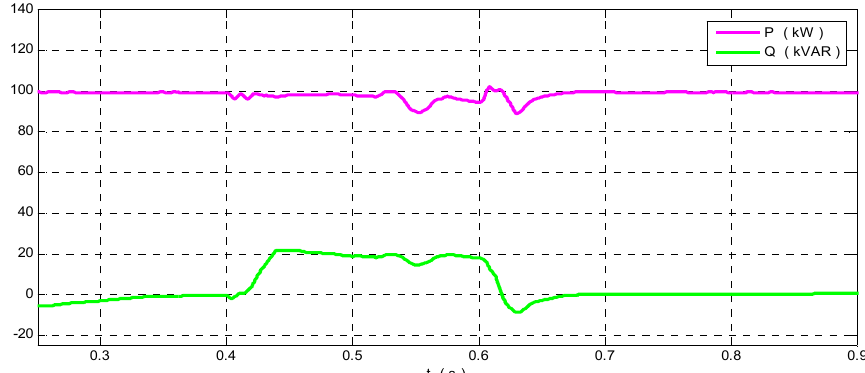
Figure 17. The active and reactive power fed to the grid.